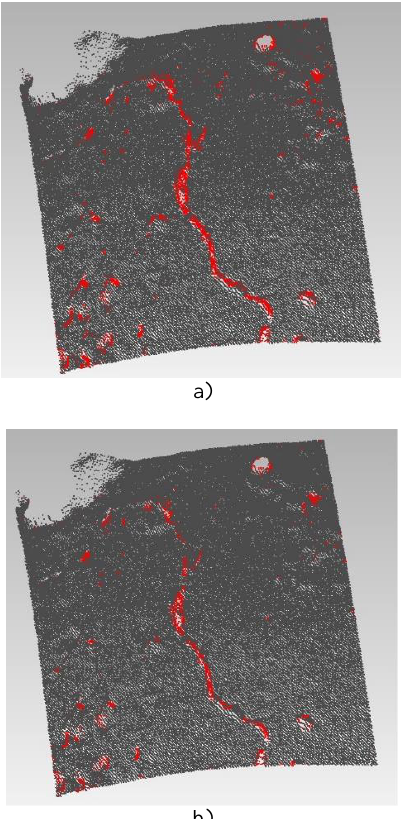
Figure 5. The two cases of pathology identification for a wall